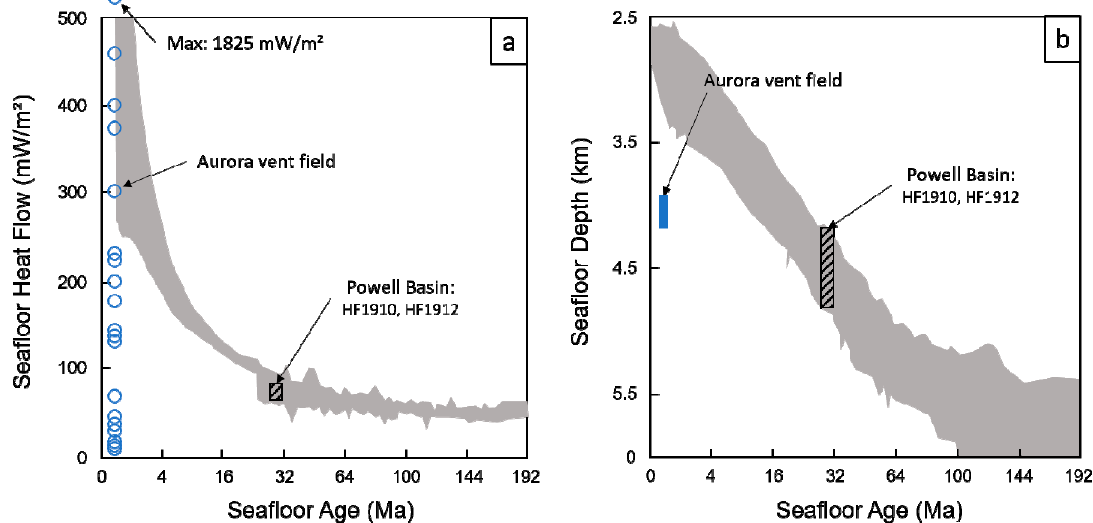
Figure 11. ( a ) Seafloor age versus seafloor heat flow from several models presented in [55] are shaded in grey. Black stripe-filled box marks where HF1910 and HF1912 approximately fall into range. Blue circles mark a selection of geothermal heat flow estimates obtain at the Aurora Vent Field. ( b ) Seafloor depth versus seafloor age from [55]. After reduction of the sedimentary cover (1500–2300 m) approximated ages and depths at station HF1910 (~2900 mbsl) and HF1912 (2780 mbsl) show a normal distribution. The Aurora Vent Field along the ultra-slow spreading Gakkel Ridge is located below predicted water depths for models of seafloor age versus depth.